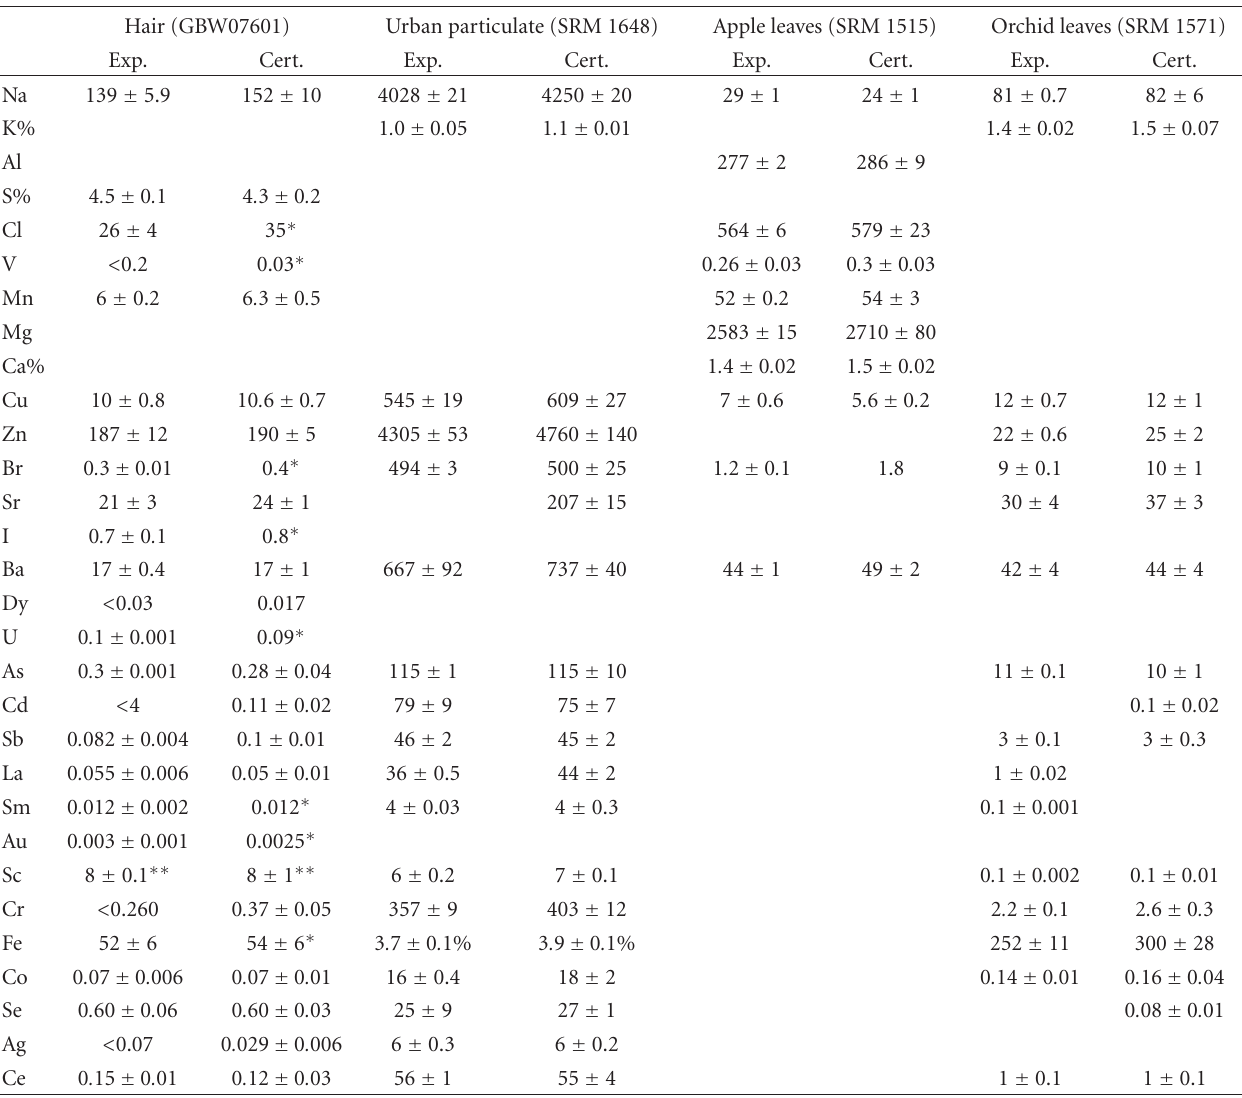
Table 1: The concentration levels of elements ( µ g/g) in four-standard reference materials obtained in this work (Exp.) together with the certified values